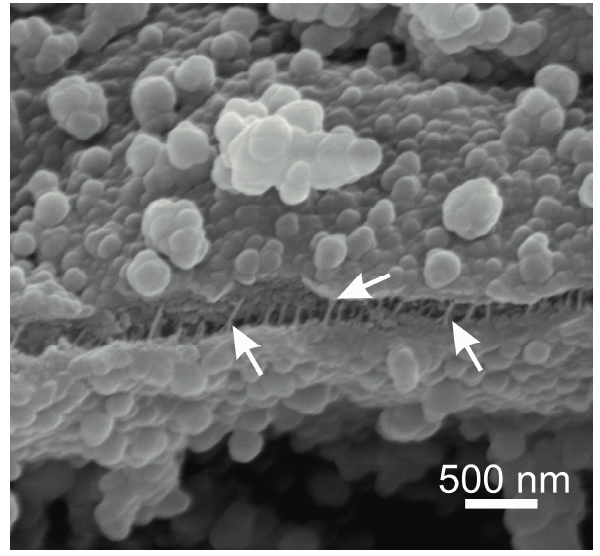
Figure 2. Typical three-dimensional fibrilar structure of chitin isolated from the skeleton of Aplysina aerophoba demosponge in ( A ) light microscopy and ( B ) fluorescent microscopy modus.